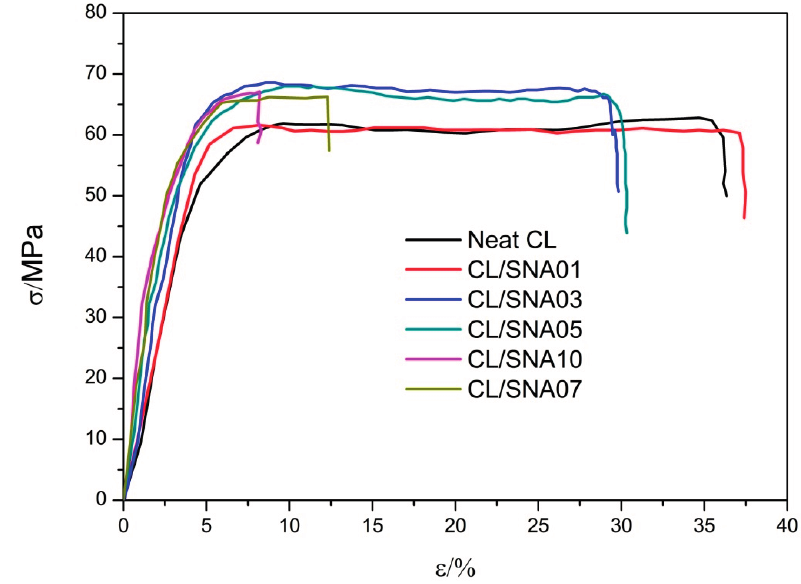
Figure 6. Typical stress-strain curves of the CL/SNA nanocomposite films under uniaxial tensile at 23